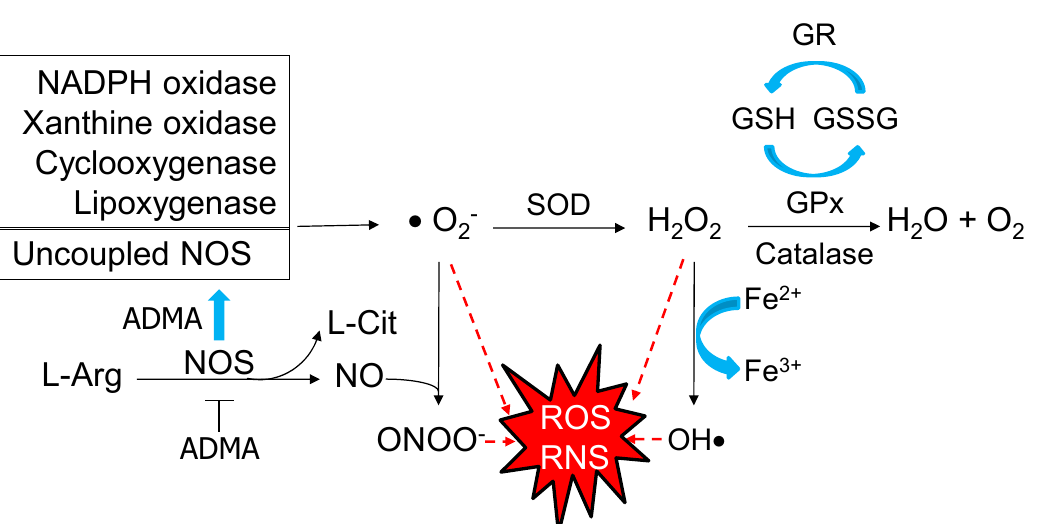
Figure 1. Schematic representation of the pathways producing reactive oxygen species (ROS) / reactive nitrogen species (RNS) and key defensive antioxidant enzymatic systems. Several enzymes produce superoxide radical (O 2 − ), such as NADPH oxidase, xanthine oxidase, cyclo-oxygenase, lipoxygenase, and uncoupled nitric oxide synthase (NOS). NOS catalyzes L-arginine (L-Arg) to produce nitric oxide (NO) and L-citrulline (L-Cit). While being inhibited by asymmetric dimethylarginine (ADMA), uncoupled NOS generates superoxide instead of NO. High level of NO can interact with superoxide to form peroxynitrite (ONOO − ). Red dashed arrow lines indicate O 2 − , hydrogen peroxide (H 2 O 2 ), hydroxyl anion (OH − ), and peroxynitrite (ONOO − ) are key elements of ROS / RNS. Conversely, excessive ROS / RNS can be counterbalanced by various antioxidant enzymes, such as superoxide dismutase (SOD), catalase, glutathione peroxidase (GPx), and glutathione reductase (GR). GPx converts reduced glutathione (GSH) into oxidized glutathione (GSSG). The generated GSSG is reduced to GSH with consumption of NADPH by GR.